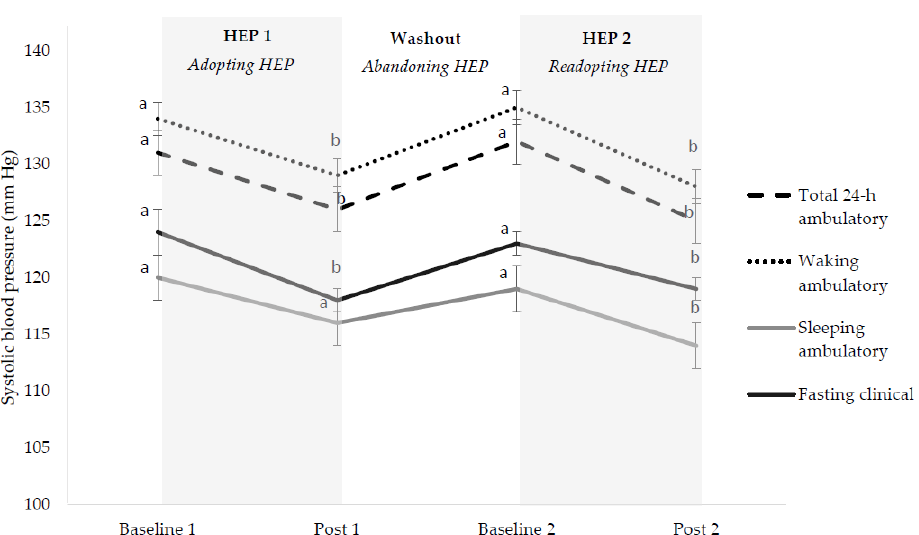
Figure 2. Systolic blood pressure changes during healthy eating pattern cycling. Results are presented as LS mean ± SEM of LS mean, n = 60. HEP; healthy eating pattern. Subjects consumed self-selected foods during baseline 1, throughout the washout (abandoning) period, and during baseline 2. Subjects consumed prescribed healthy eating patterns during post 1 and post 2. Different letter superscripts represent different values ( p < 0.05). Results for diastolic blood pressures followed a similar pattern; see Table S1.